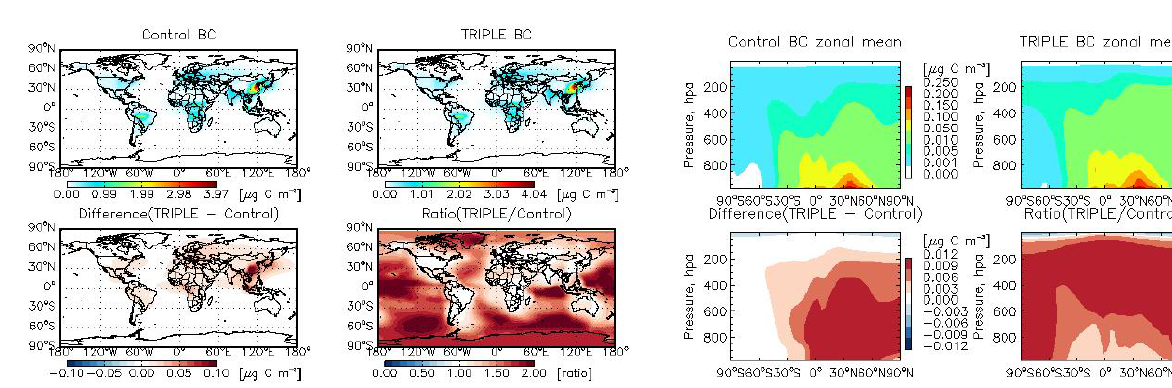
Fig. 7b. Same as Fig. 7a but for OC.